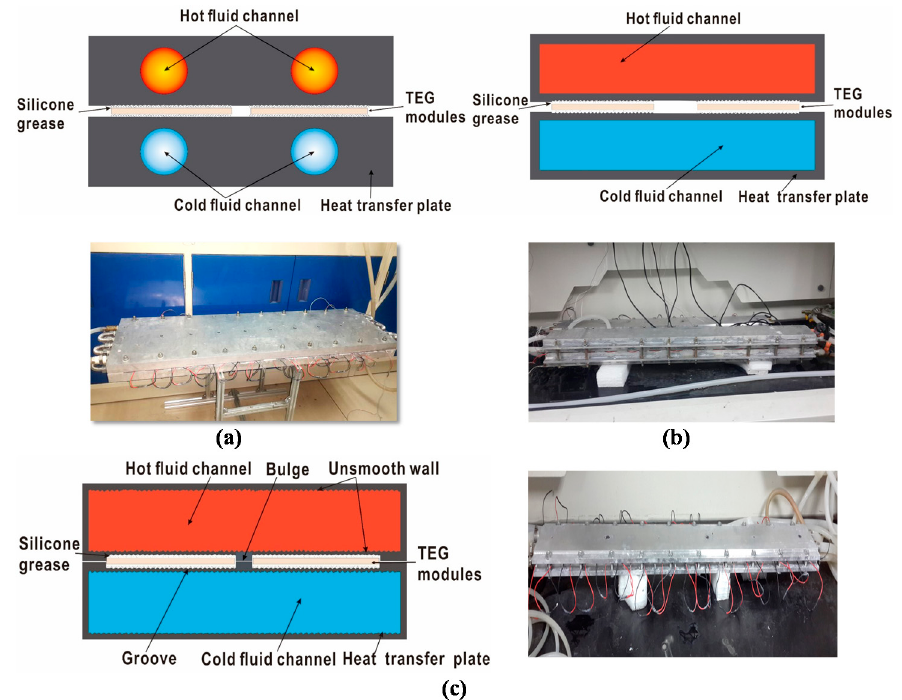
Figure 5. Different model structure: ( a ) Structure diagram of Model #1; ( b ) Structure diagram of Model #2; ( c ) Structure diagram of Model #3.